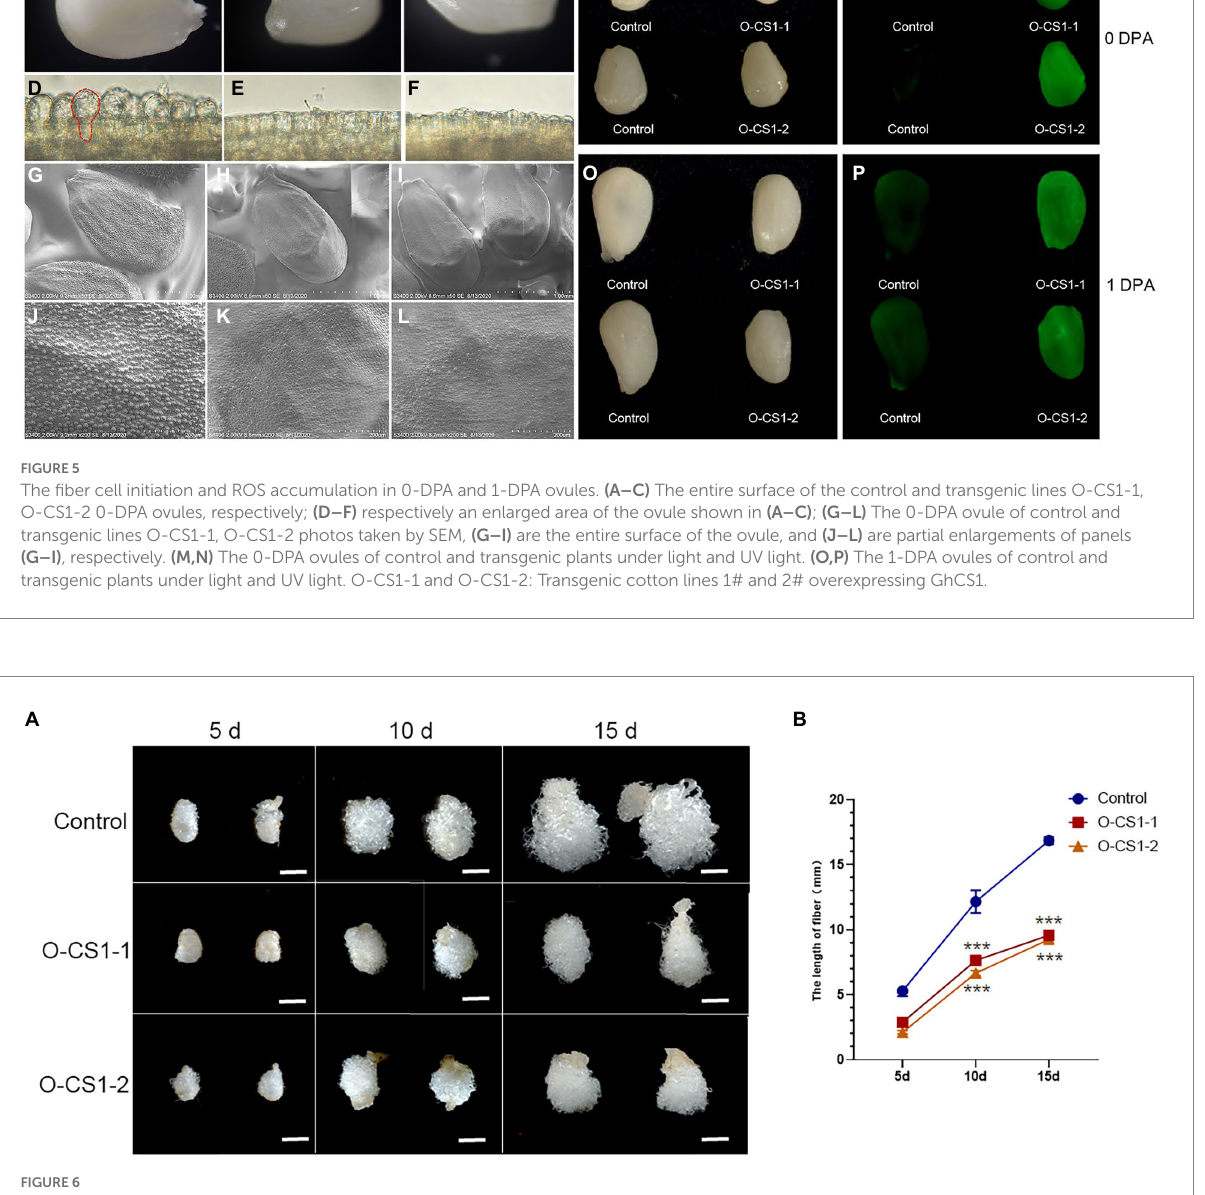
detected, and the content of Cer molecules that containing VLCFA chains (C22, C24, and C26) increased significantly in transgenic cotton ovules, especially d18:1/22:0, d18:1/24:0, and d18:0/24 increased more than twice (Figure 7D), indicating that the dominant FA substrate of GhCS1 is VLCFA. A total of 22 Phyto-Cer molecules were detected, among which the content of 8 Phyto-Cer molecules (Phyto